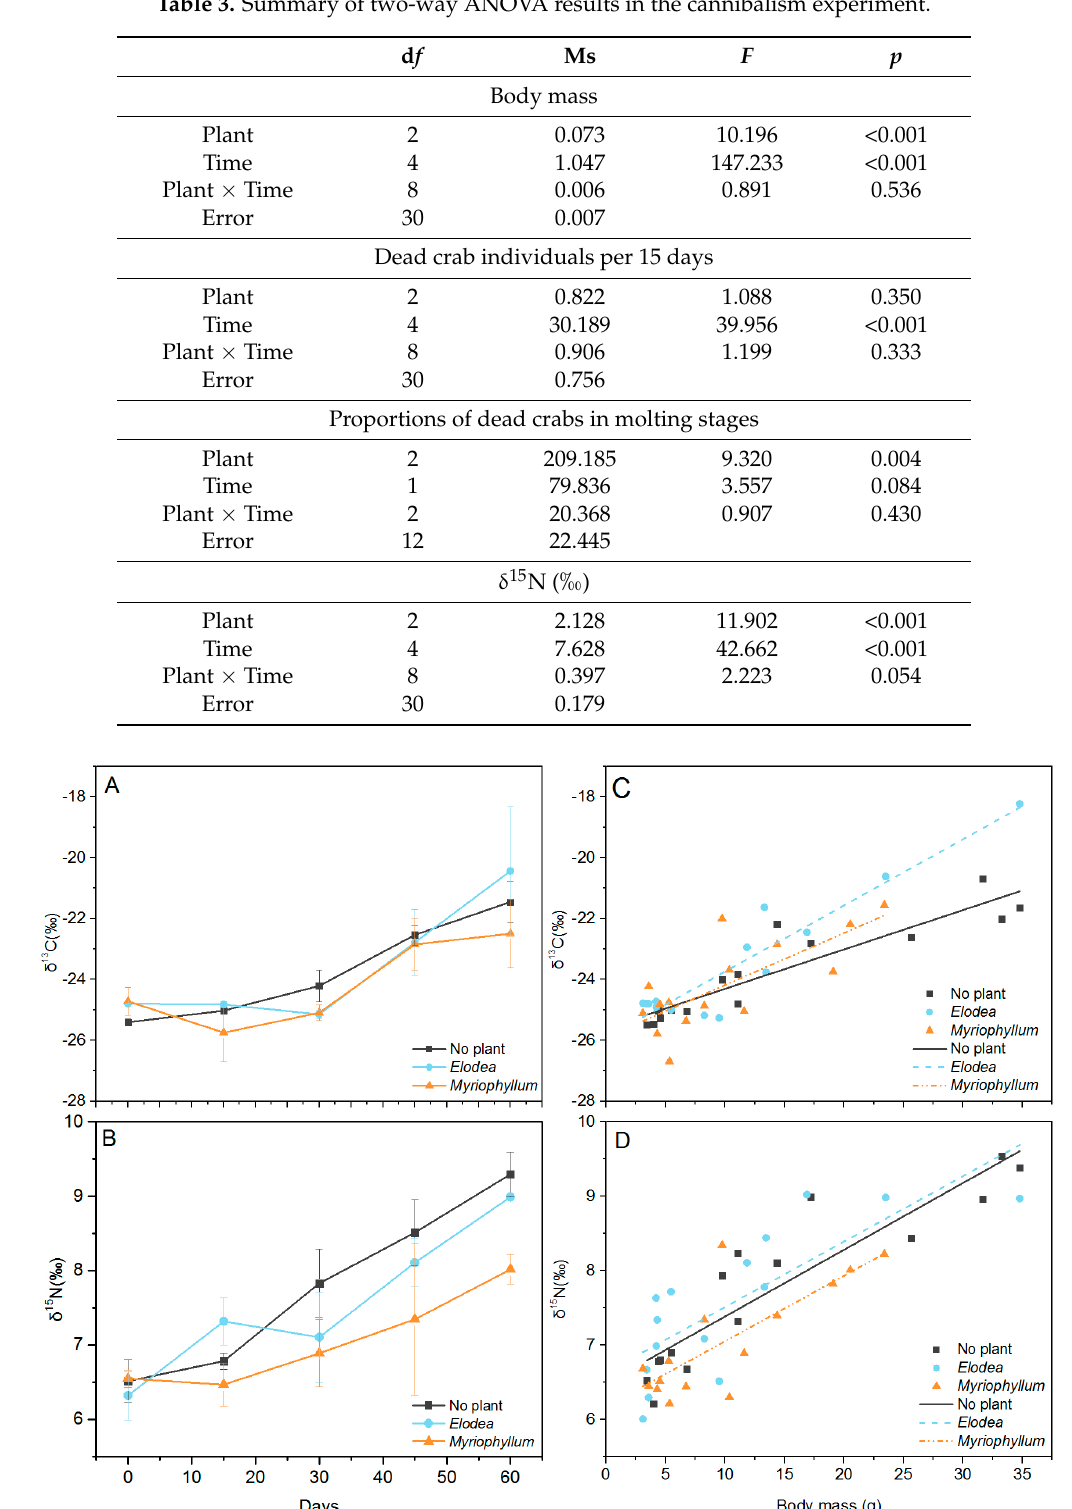
Figure 6. Temporal trend of δ 13 C (‰) ( A ) and δ 15 N (‰) ( B ) of crabs and the relationship between body mass, δ 13 C (‰) ( C ) and δ 15 N (‰) ( D ) of crabs throughout the experimental period in the cannibalism experiment. Error bars represent standard deviation ( n = 3). Lines represent linear fits for body mass versus δ 13 C (‰) and body mass versus δ 15 N (‰). Correlations were significant at p = 0.01.